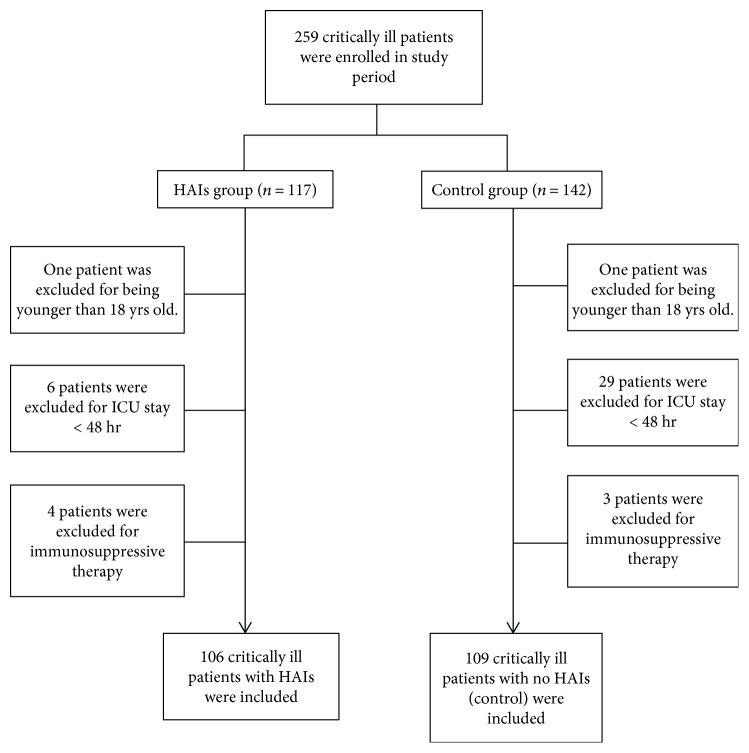
Flow chart of inclusion and exclusion criteria in the HAIs and control groups. From June 1, 2016, to November 30, 2016, 259 critically ill patients were screened for the study, including 117 HAIs patients and 142 controls. In the HAIs group, eleven HAIs patients were excluded from the study due to ICU stay of less than 48 hours (n = 6), young age (n = 1), or receipt of immunosuppressive therapy (n = 4), while 33 controls were excluded for less than 48-hour ICU stay (n = 29), young age (n = 1), or receipt of immunosuppressive therapy (n = 3).